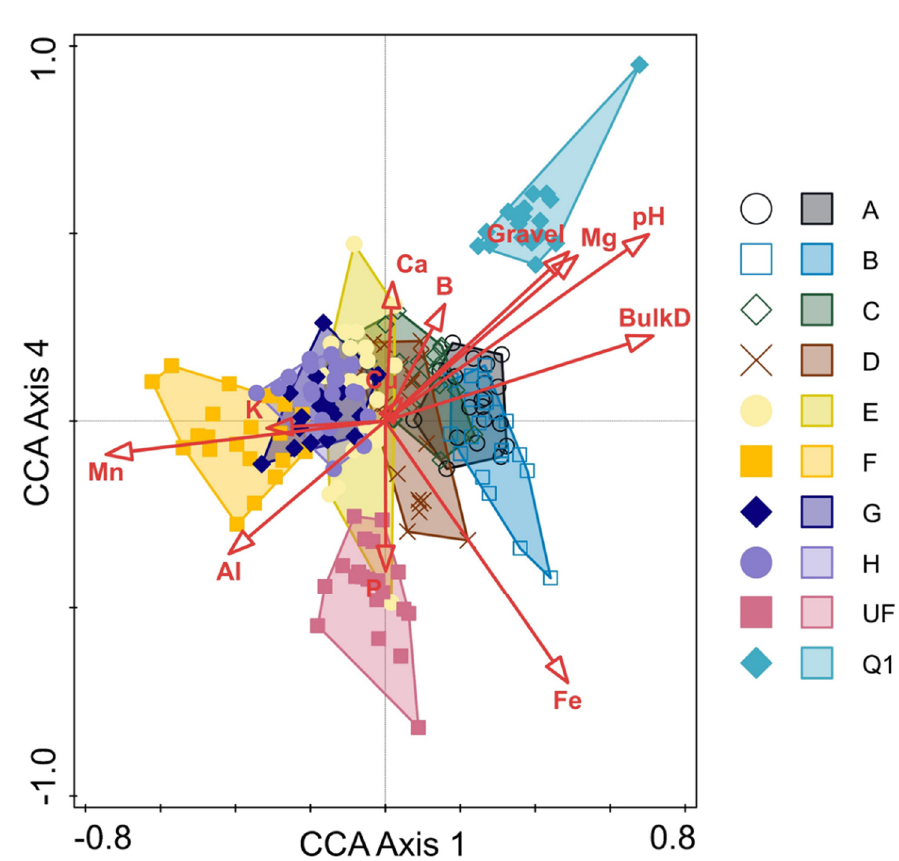
Figure A1. First and fourth axes of Canonical Correspondence Analysis (CCA) ordination diagram showing delineation of quadrats based on plant species composition as explained by environmental variables in eight plots (A–H) within the 70-year-old abandoned quarry (Q70) and in the reference plots at an urban forest (UF) and a recently decommissioned quarry (Q1) in Jefferson City, Missouri, USA. Symbols show the 200 quadrats in which soil variables were measured. The arrows point toward the direction of the steepest increase of values of environmental variables; the coordinates of an arrow tip are correlations of the environmental variable with the two ordination axes (e.g., soil P concentration is highly correlated with Axis 1, but P does not correlate with Axis 2). Separation of plots along the first axis indicated distinct understory vegetation communities at the quarry top and the quarry floor. UF also has distinctive understory as seen by separation along the 4th axis.